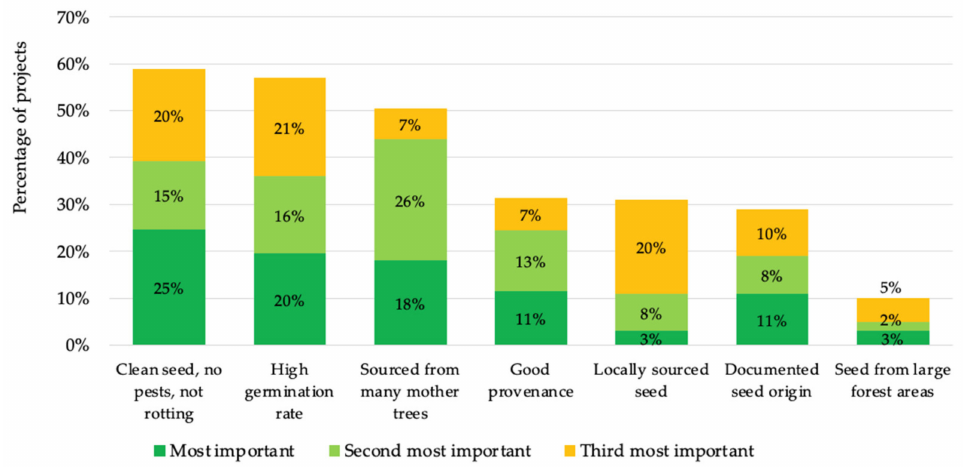
Figure 2. Most decisive characteristics defining high-quality seed from the perspective of the surveyed FLR practitioners (in % of projects, total of 61